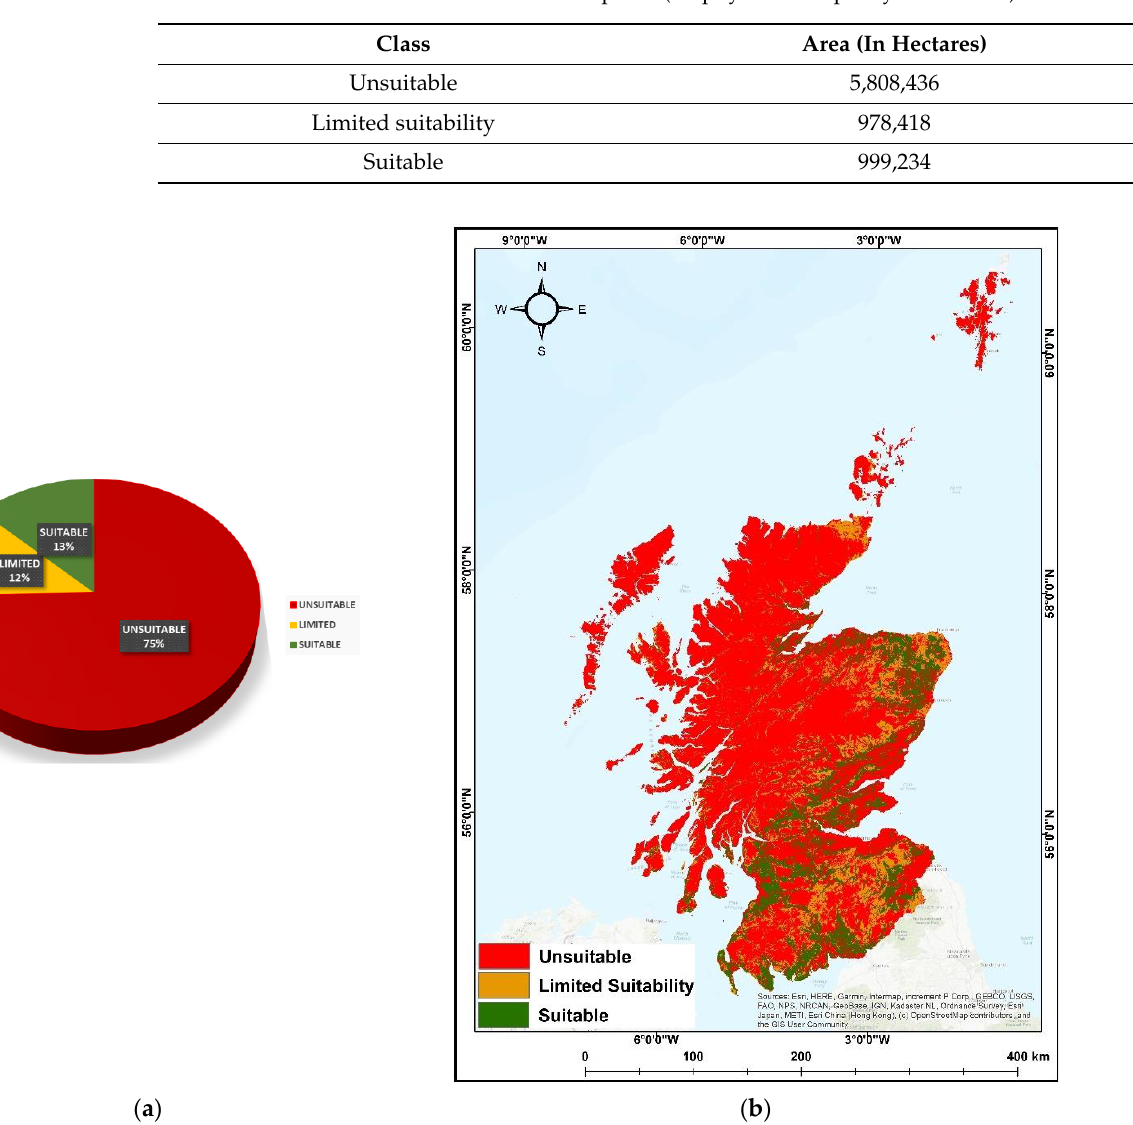
Figure 6. ( a ) Percentage of land area in Scotland unsuitable/limited/suitable considering overall suitability (biophysical and policy constraints). ( b ) The overall suitability map of Sitka spruce in Scotland.